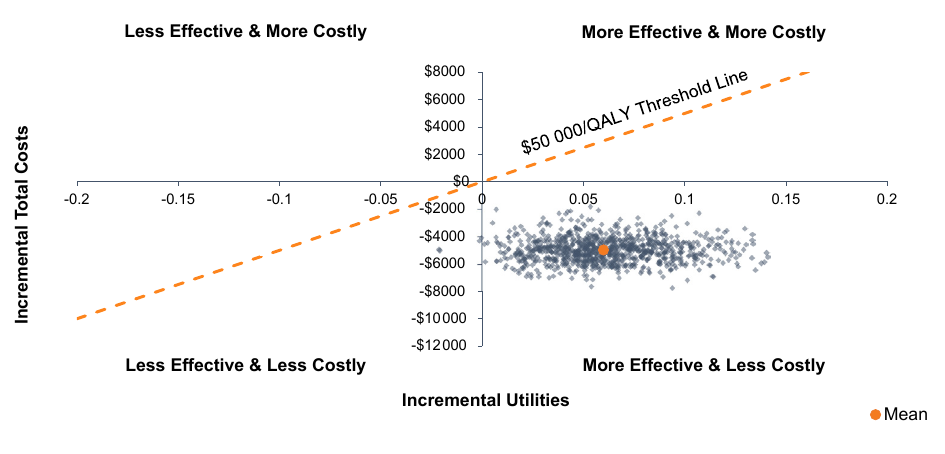
Figure 4. Scatter Plot of Incremental Costs and QALYs Gained at 4 Years for PUL and